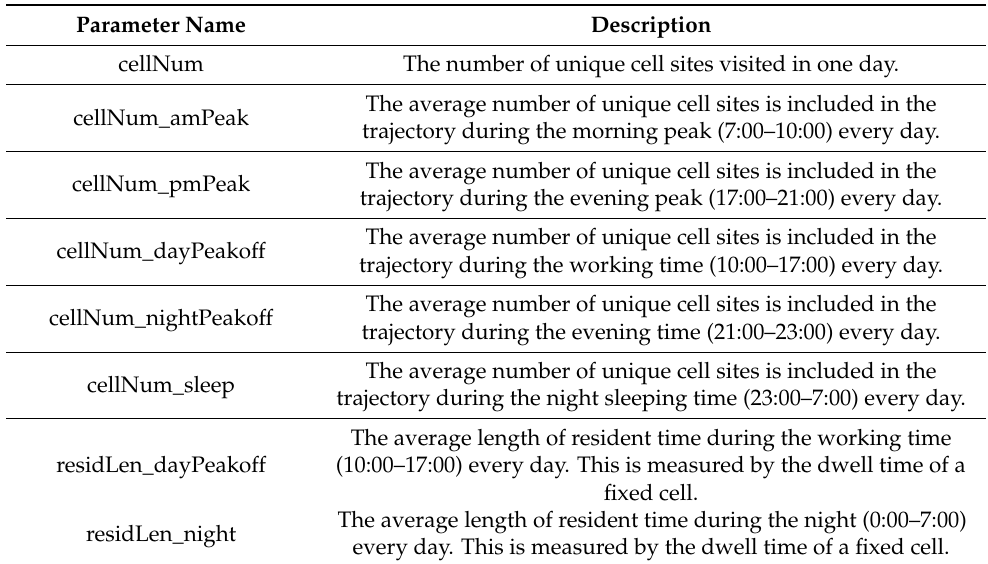
Table 2. Parameter name and corresponding